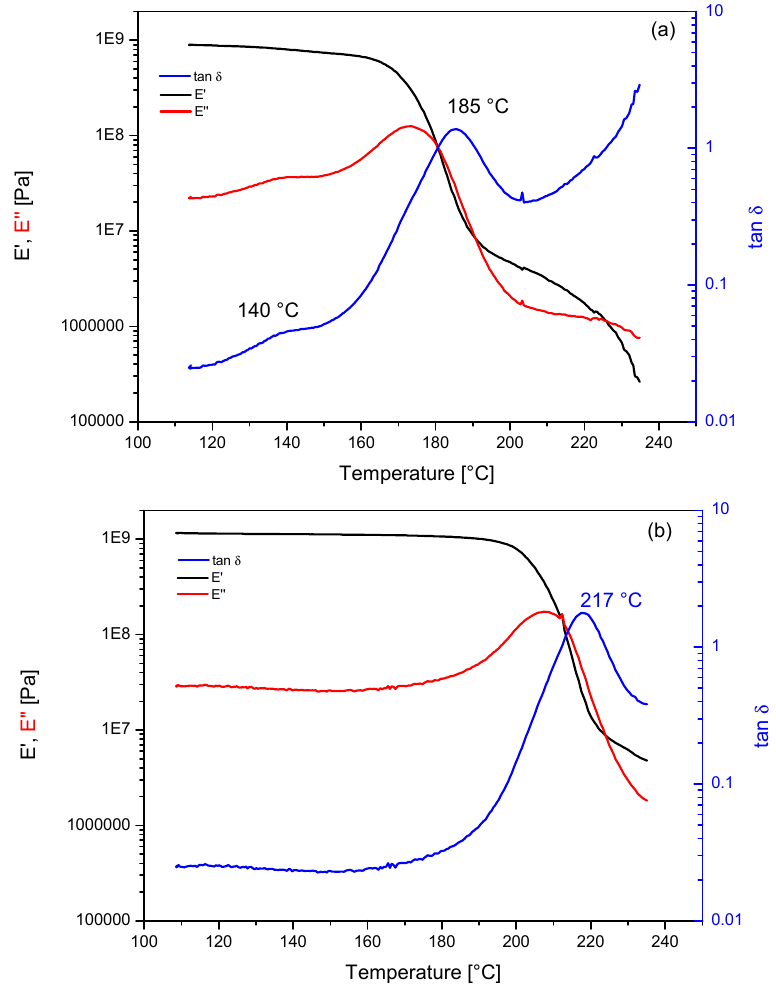
Figure 4. Dynamic mechanical analysis for PEI based systems: ( a ) Ultem 9085 and ( b ) PEI.